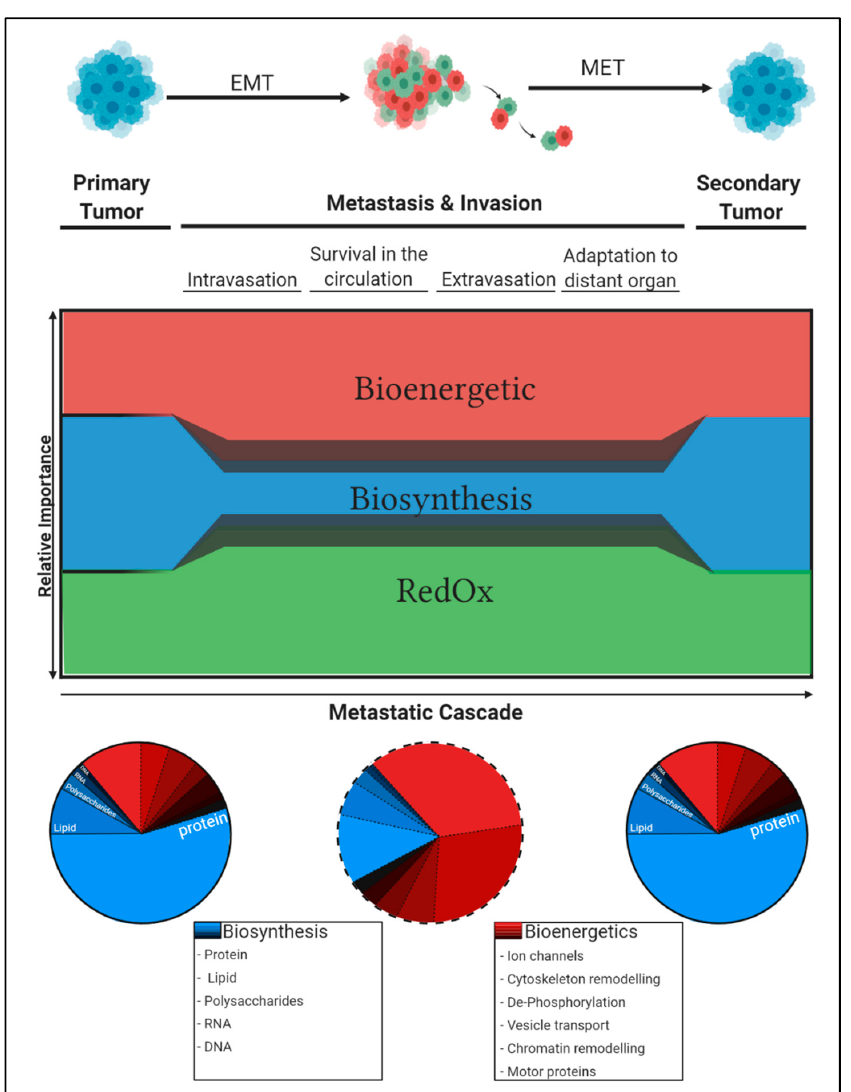
Figure 3. Flexible metabolic conversion of available carbon sources allows cancer cells to adapt to changing metabolic needs along the metastatic cascade. According to the cellular needs, the available carbon atoms from nutrients are distributed between the three main metabolic sinks. The relative amount of carbon atoms that is invested for proliferation in primary tumour cells prohibits extensive energy allocation for invasion and metastasis. However, under growth-arrested conditions, cells spend less nutrients on biosynthesis and can reallocate the gained spare carbons to promote an invasive phenotype by investing in enhanced cellular energy production and/or improved anti- oxidant defence. Thus, upon proliferation within the primary tumour and in the developed metastasis (left and right pie chart), the cells invest most energy for building block production (protein, lipid, DNA/RNA synthesis). However, during the metastatic process (middle pie chart), the metastatic cells switch from anabolic to catabolic metabolism and energy might be redistributed to support cell invasion. Author Contributions: Conceptualization, J.M. and N.K.; writing – original draft preparation, M.B., C.D., L.N., N.K., and J.M.; visualization, M.B., C.D., and L.N.; writing – review and editing M.B., N.K., and J.M.; supervision N.K. and J.M. All authors have read and agreed to the published version of the manuscript.